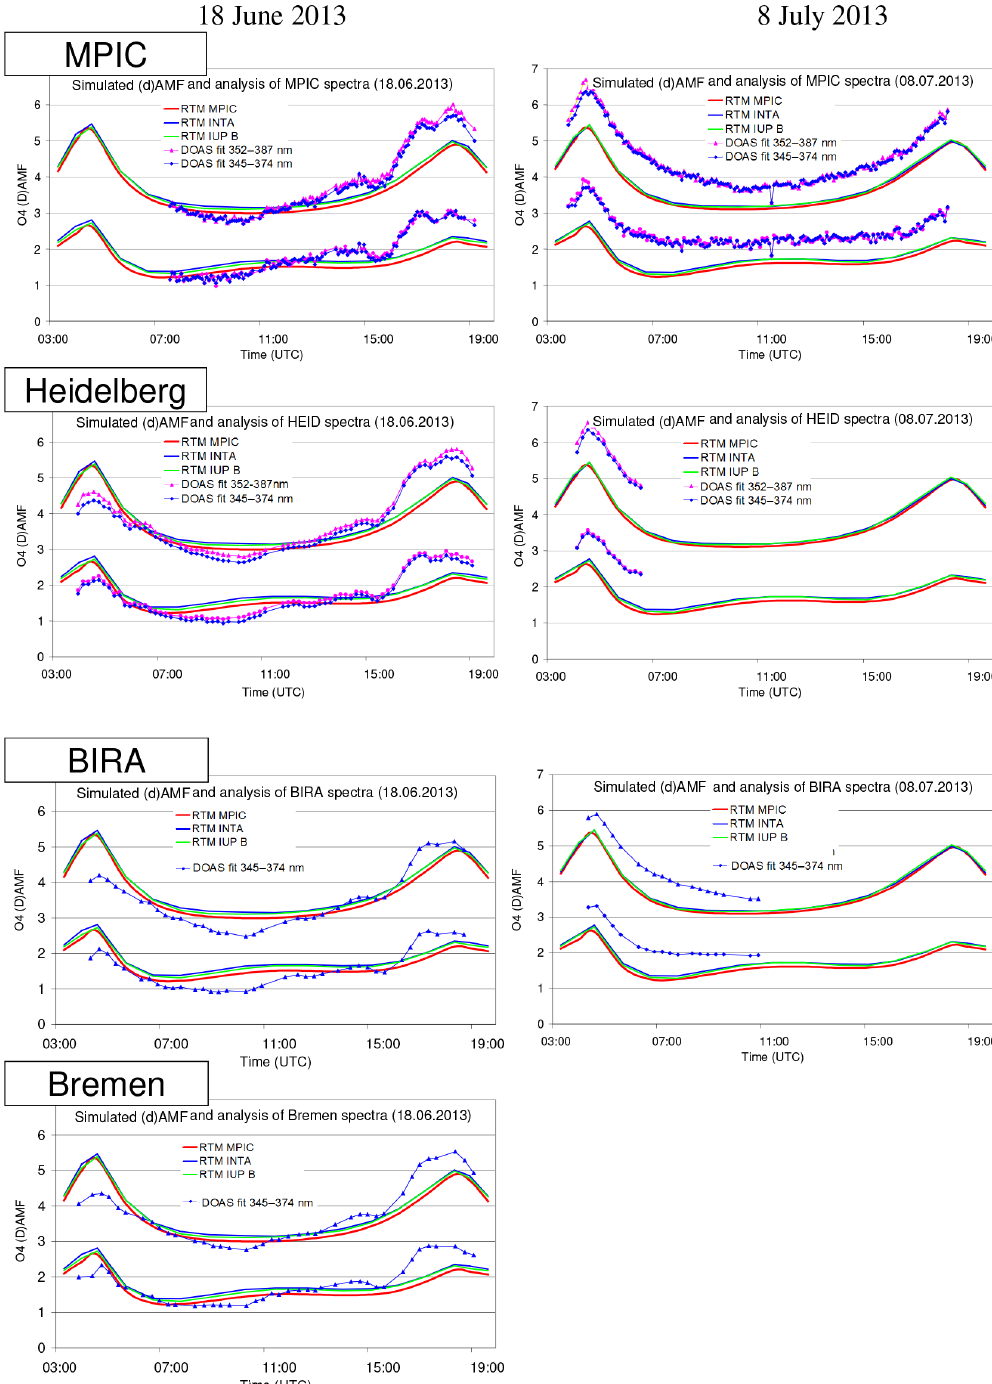
Figure 15. Comparison of measured and simulated O 4 (d)AMFs for both selected days. Measurements are from four different instruments but are analysed by MPIC using the standard settings (see Table 7). Simulations are performed by three different groups using Mie phase functions and otherwise the standard settings (see Table